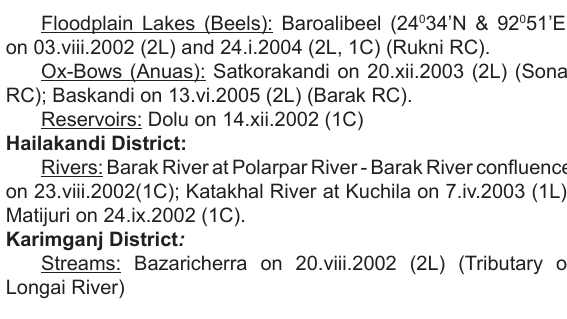
Table 1. Site records of softshell turtles from Barak Valley, Assam, northeastern